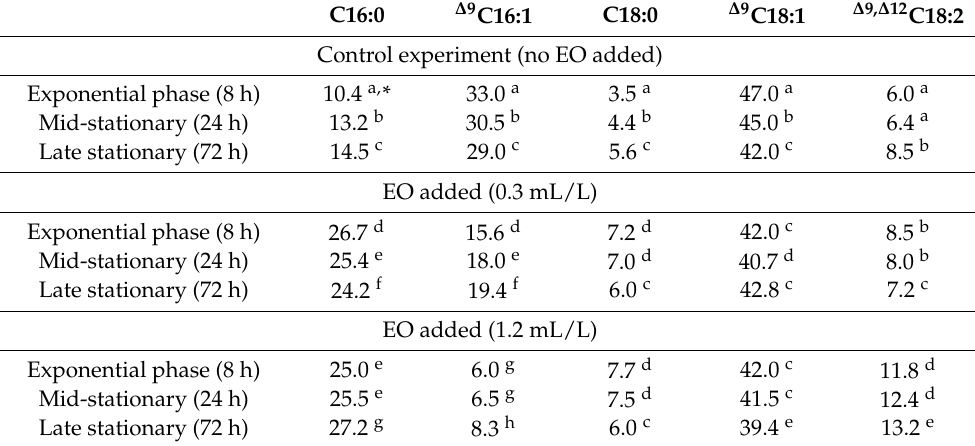
Table 4. Fatty acid composition (%, w / w ) of cellular lipids produced by Saccharomyces cerevisiae in the absence and presence of